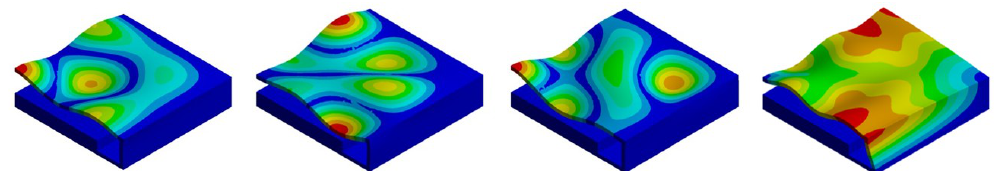
Figure 12. Four package displacement eigenmodes around the fundamental frequency: 6th mode shape at 81.46 kHz ( left ), 7th mode shape at 104.18 kHz ( center-left ), 8th mode shape at 104.45 kHz ( center-right ) 16th mode shape at 158.110 kHz ( right ).